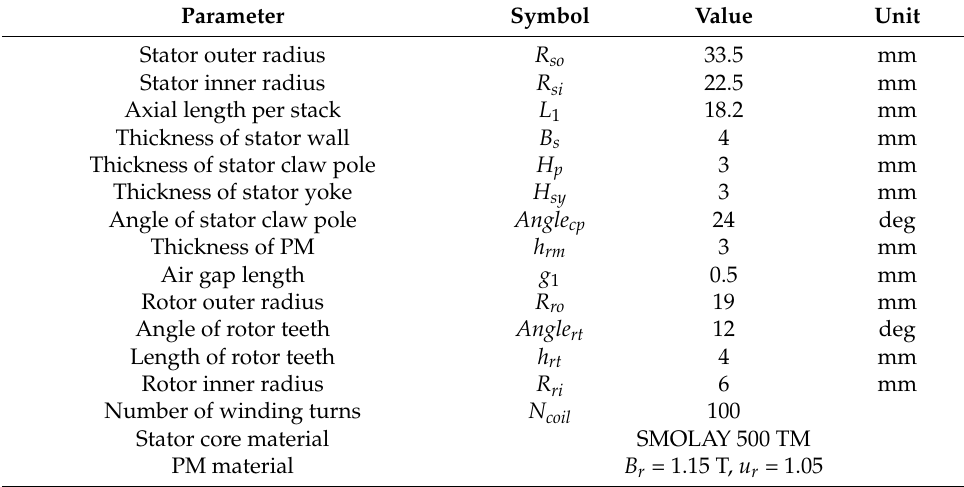
Figure 3. Optimization of the ratio of stator claw pole to the height of rotor teeth: ( a ) EM torque; ( b ) Core loss. Table 2. Main parameters of proposed FRCPM.